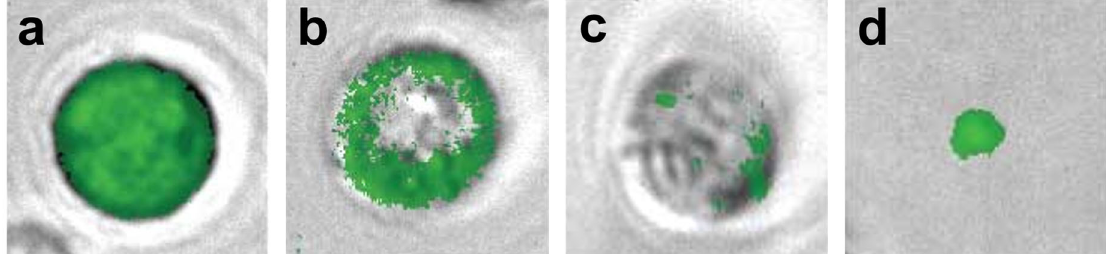
Figure 5. Different distribution of dextrans detected on microscopic images of fluorescently labelled dextrans presented as overlay of brightfield and fluorescence channel: uniform distribution ( a ), confined to cytosol ( b ), clusters ( c ) and debris ( d ).